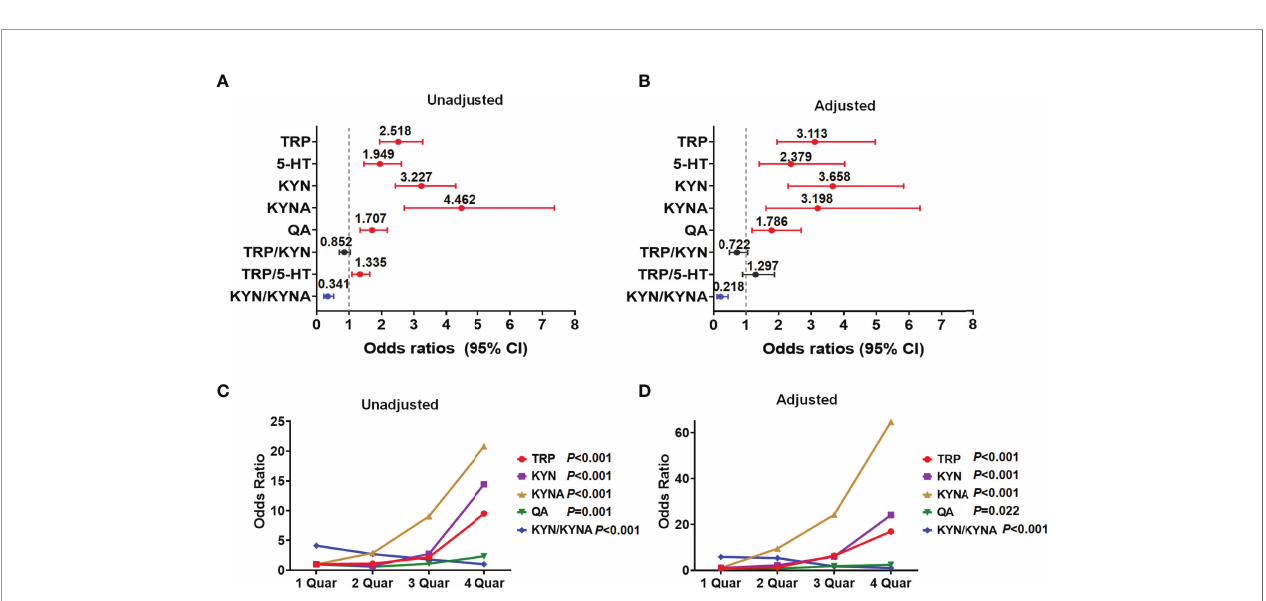
FIGURE 2 | Identi fi cation of metabolites in tryptophan-kynurenine pathway associated with PCOS. (A) Unadjusted odds ratios (95% CIs) of PCOS per 1 SD change in plasma abundance of each metabolite. (B) The odds ratios (95% CIs) of PCOS per 1 SD increase in plasma abundance of each metabolite adjusted for baseline age, BMI, LH, androstenedione, and AMH. (C, D) Concentration-effect relationship of metabolites in tryptophan-kynurenine pathway associated with PCOS. The prevalence of PCOS was dramatically raised with the quartiles of TRP, tryptophan; KYN, kynurenine; KYNA,kynurenic acid and QA, quinolinic acid while decreased with quartiles of KYN/KYNA, before (C) and after (D) adjusting for baseline age, BMI, LH, androstenedione and AMH.